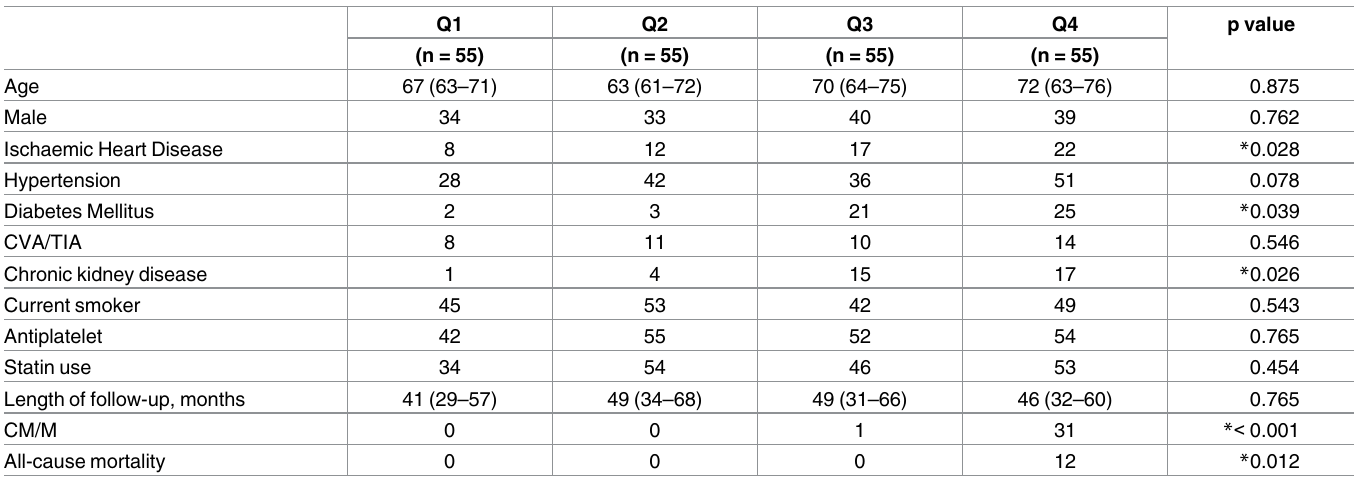
Table 2. Baseline characteristic and clinical outcomes by total LLAC score